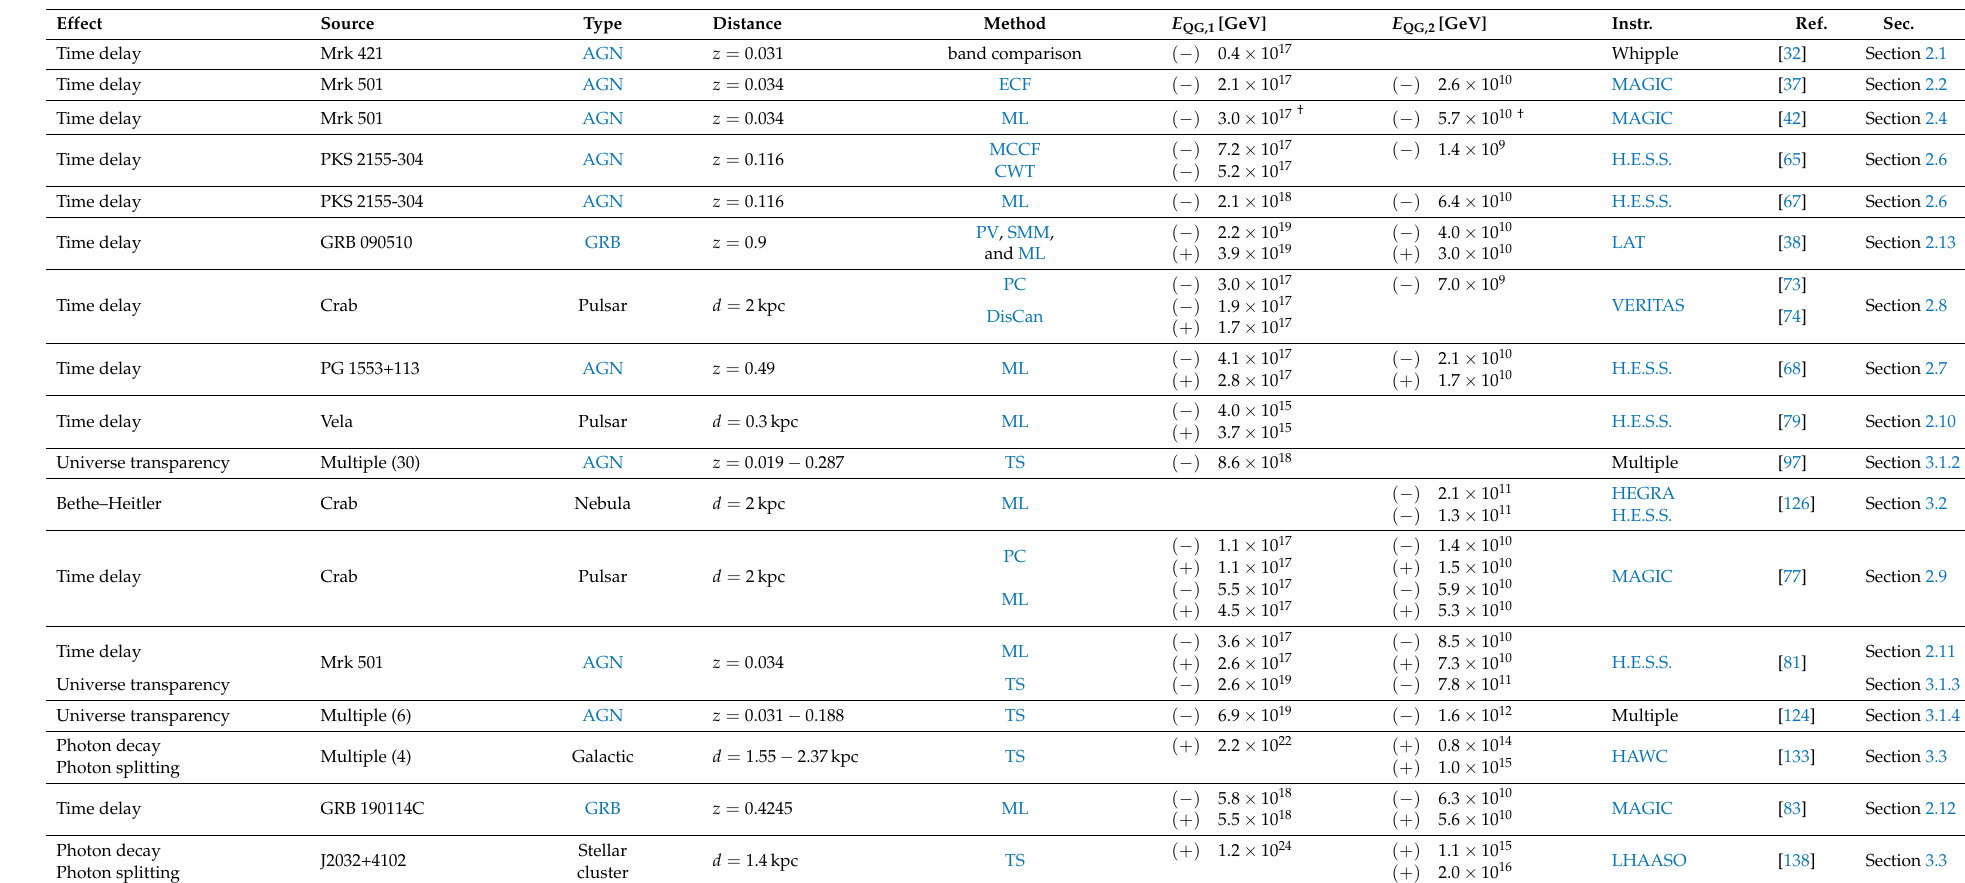
Table 2. Chronological census of bounds on the LIV energy scale as reported in the respective publications. The columns show from left to right: (i) LIV effect used to probe the QG, (ii) name of the observed source (when more than one source was used, we give the numner of the sources in the sample), (iii) type of the observed source, (iv) source redshift for extragalactic sources, and distance in kpc for sources in Milky Way, (v) analysis method used to perform the test, (vi) lower limit on the linear term in the modified photon dispersion relation, (vii) lower limit on the quadratic term in the modified photon dispersion relation, (viii) the experiment which produced the data sample, (ix) reference for the respective publication, (x) section in which the result was discussed in this work. Markers (+) and ( − ) in columns (vi) and (vii) represent superluminal and subluminal behaviours, respectively. The lower limits are expressed on the 95% confidence level. Symbol † represents the best fit result in case where the estimated parameter was > 2 σ away from Lorentz invariant